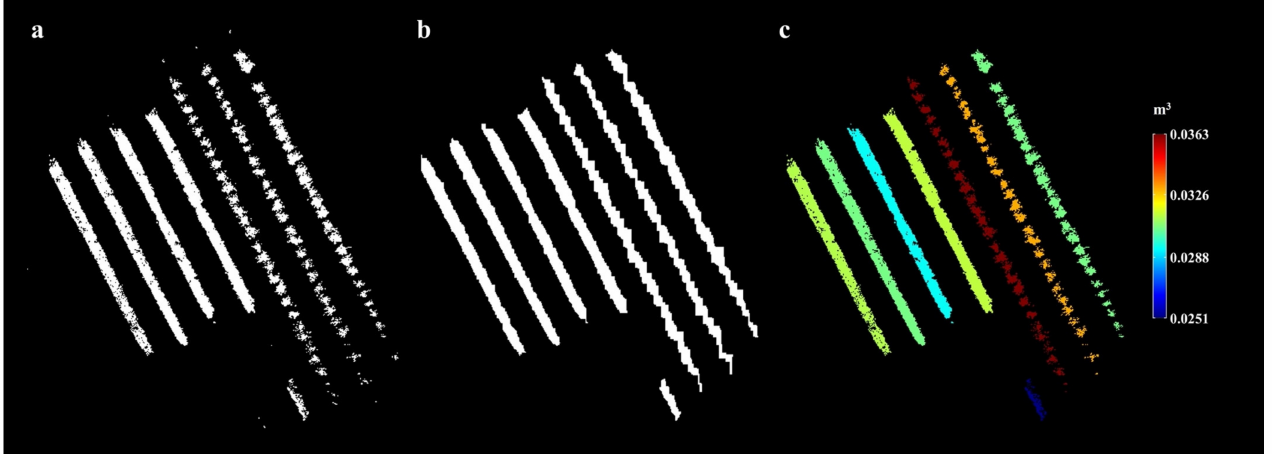
Figure A9. The blossom containing volume map generation process using the sample blossom point cloud downsampled by a 0.1 m × 0.1 m × 0.1 m blossom grid filter: ( a ) raw blossom mask; ( b ) closed, cleaned blossom mask; ( c ) blossom containing volume